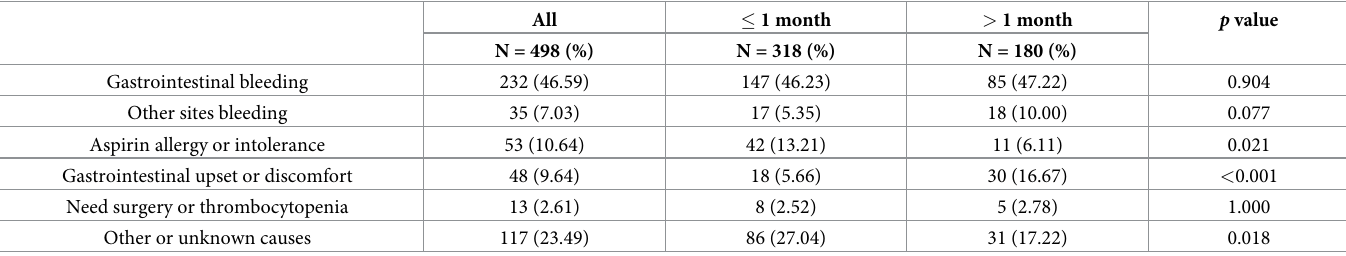
Table 2. Reasons for premature discontinuation of